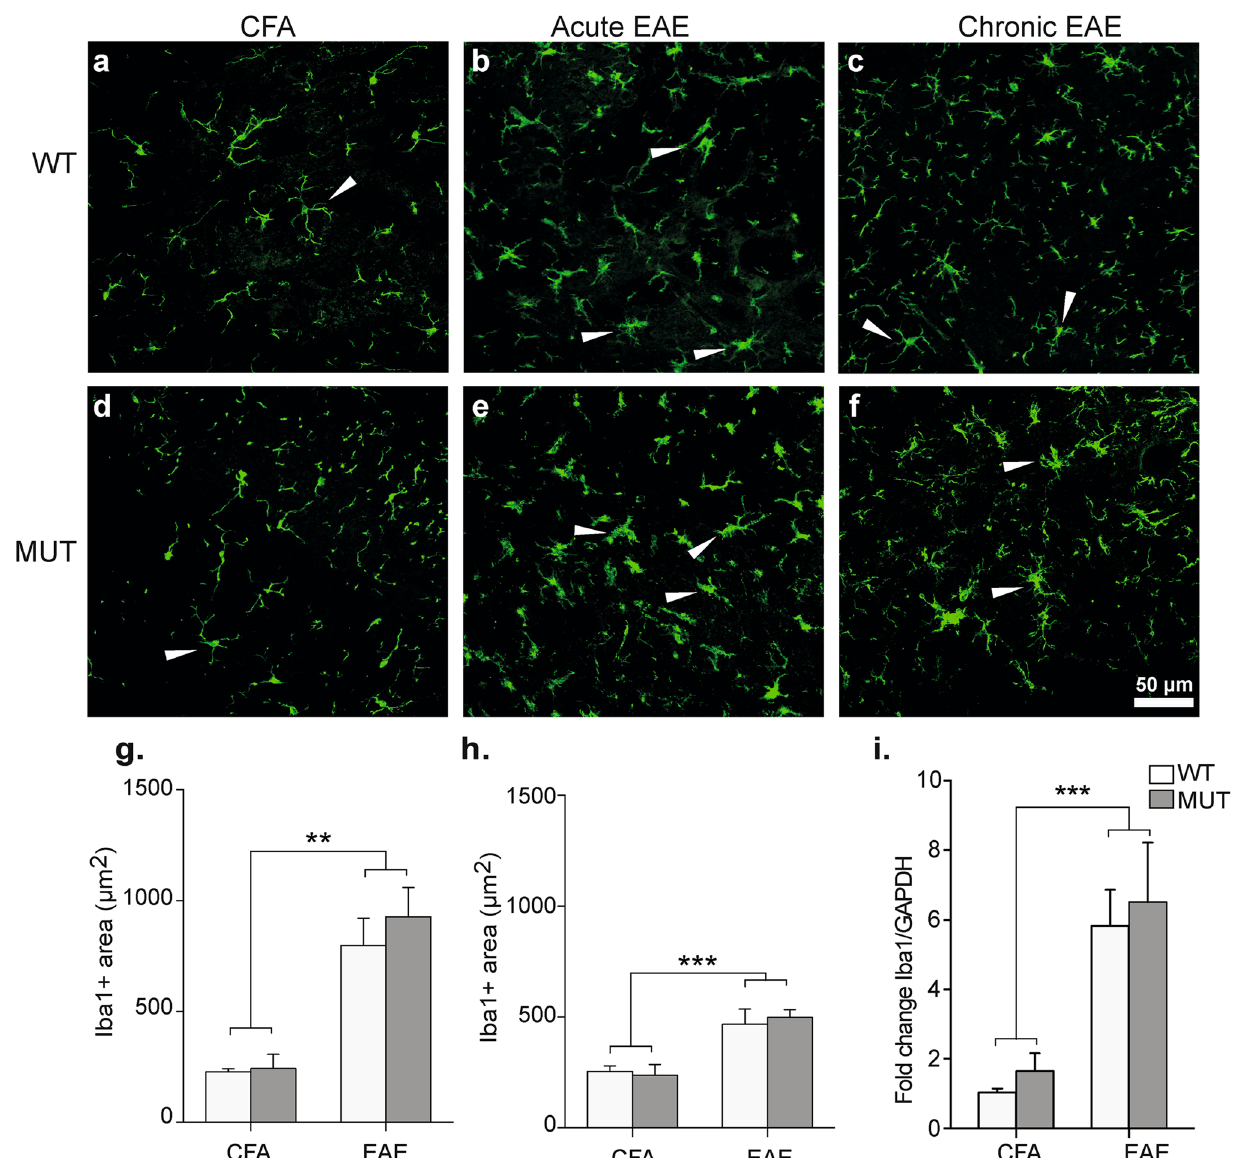
Figure 7. Microgliosis and Iba-1 expression analysis. ( a–f ) Representative sections of lumbar spinal cord from WT and MUT mice obtained at acute or chronic EAE stages and stained for the microglial marker Iba-1. Microglial cells from control CFA mice ( a , d ) showed small somas and thin projections. During acute EAE ( b,e ), microglia cell soma increased in size and projections became shorter and wider, indicative of microgliosis and microglial activation (white arrowheads). At chronic EAE stage ( c,f ) less cells evidenced an activated morphology (white arrowheads). Scale Bar: 50 μm. ( g,h ) Total area occupied by Iba-1 (µm 2 ) was measured by a particle size exclusion analysis. In ( g ) acute and ( h ) chronic stages, Iba-1 + area was significantly higher in both WT-EAE and MUT-EAE group compared to CFA groups. Data is presented as mean ± SEM. A two-factor ANOVA test and Tukey post hoc test was performed. **p < 0.002, ***p < 0.0002. CFA-WT n = 4; CFA-MUT n = 4; EAE-WT n = 5; EAE-MUT n = 5, for each stage. ( i ) At 30 dpi, lumbar spinal cords were obtained from CFA and EAE mice in order to isolate the mRNA and analyze the expression levels of Iba-1 by Real Time RT-PCR. GAPDH was used as the housekeeping gene. Graph shows the fold change of expression calculated as 2 −ΔΔCT . Iba-1 relative expression levels were higher in all mice immunized with MOG compared to CFA and it was similar between WT and MUT mice. All values are presented as mean ± SEM. Two-way ANOVA and Tukey post hoc test were performed. ***p < 0.0021. WT-CFA n = 6; MUT-CFA n = 8; WT-EAE n = 6; MUT-EAE n =